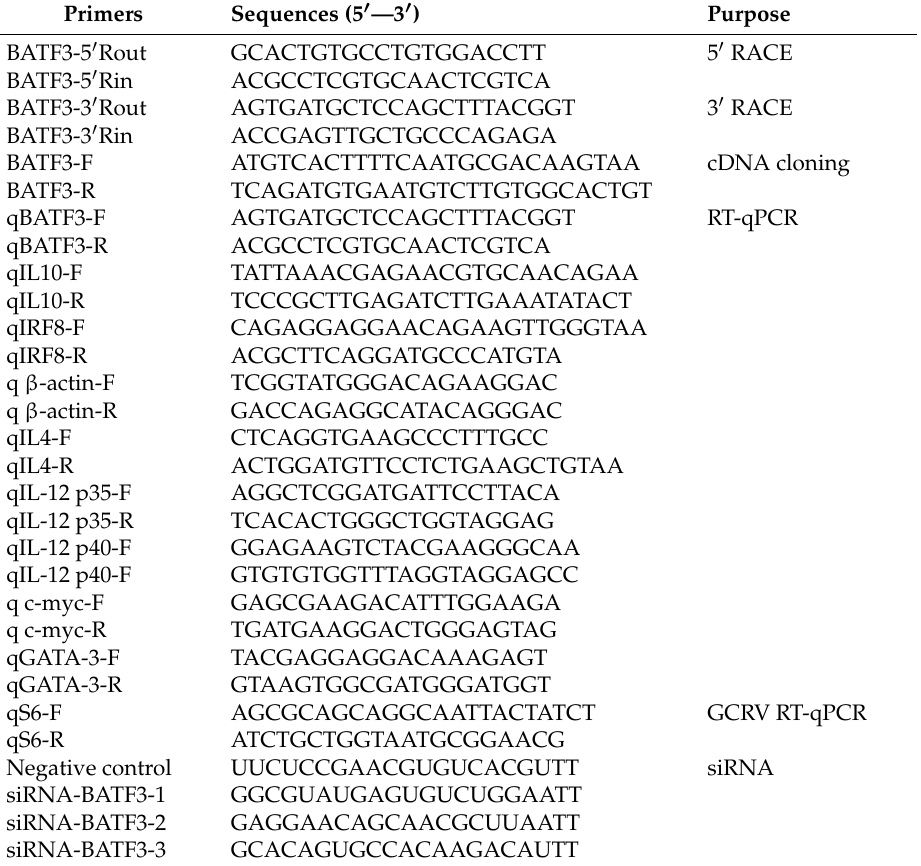
Table 2. Primers used for cloning and RT-qPCR and the siRNA sequence